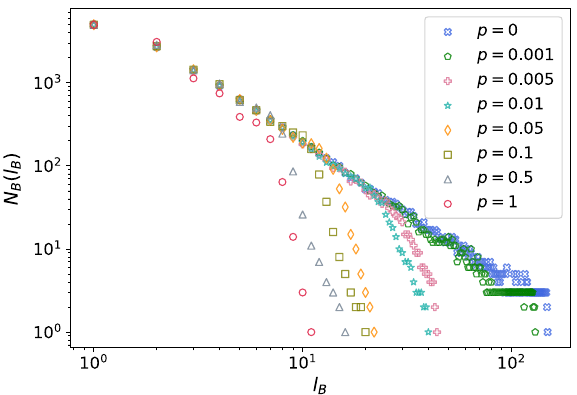
Fig. 11 Illustration of the fractality of the LSwTM for different choices of parameter p with n 1 = 50, n 2 =